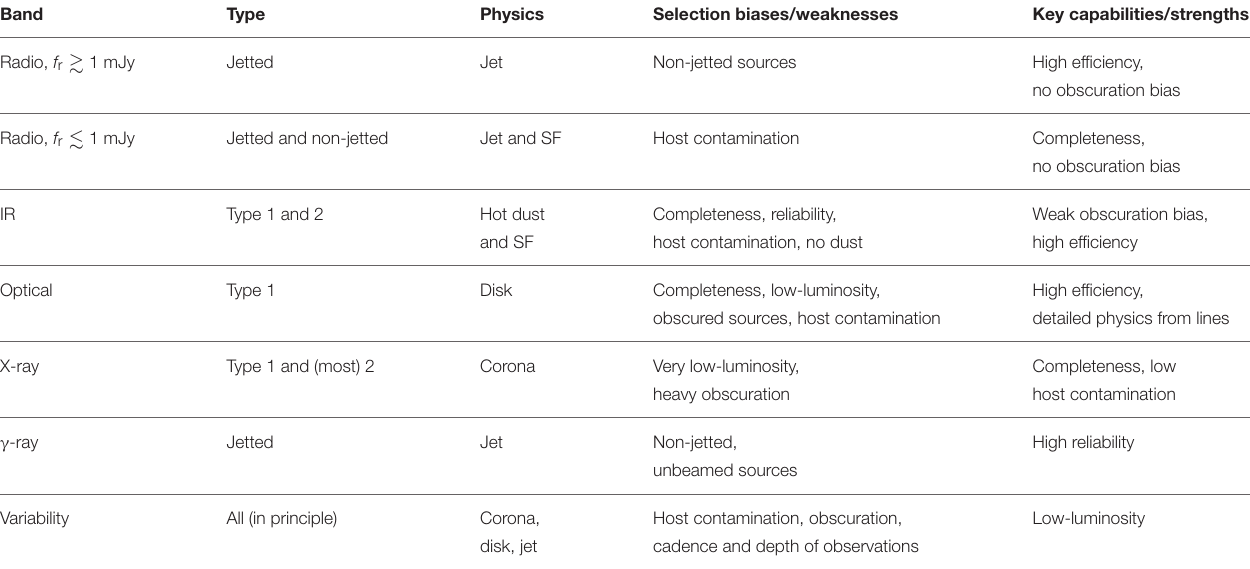
TABLE 2 | A multi-wavelength overview of AGN highlighting the different selection biases (weaknesses) and key capabilities (strengths). Band Type Physics Selection biases/weaknesses Key